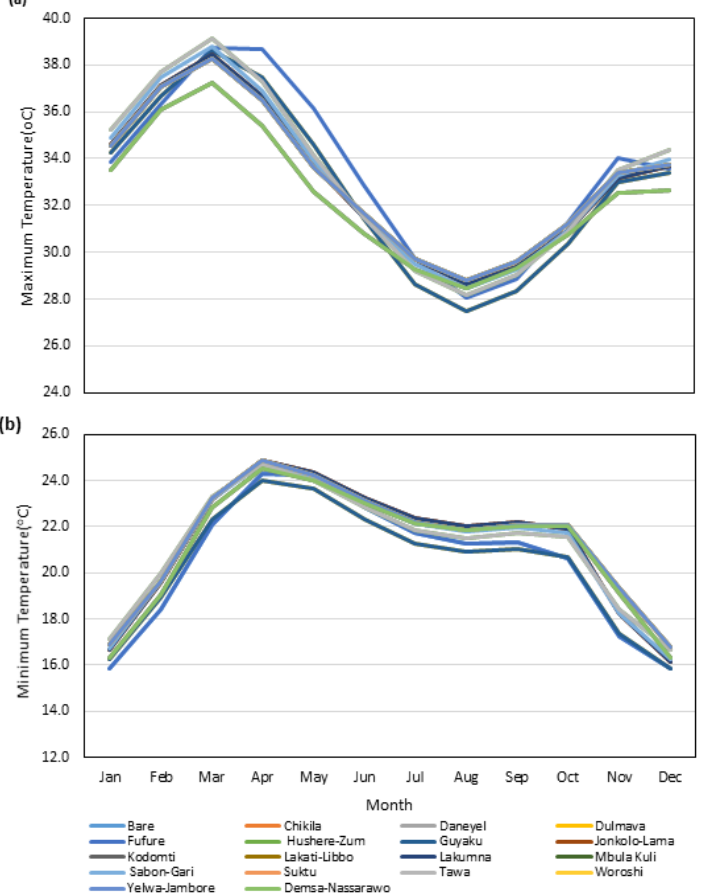
Figure 3. Average monthly variation of ( a ) maximum temperatures and ( b ) minimum temperatures between 1985 and 2010 across the simulation sites in Adamawa State. The coefficients of variation (CV) ranged from 3.0 to 3.7% for maximum temperature and 2.0 to 2.3% for minimum temperature. Table 8. Analysis of mean monthly, seasonal rainfall (mm) and level of variability across the simu- lation sites in Borno State from 1985 to 2010.